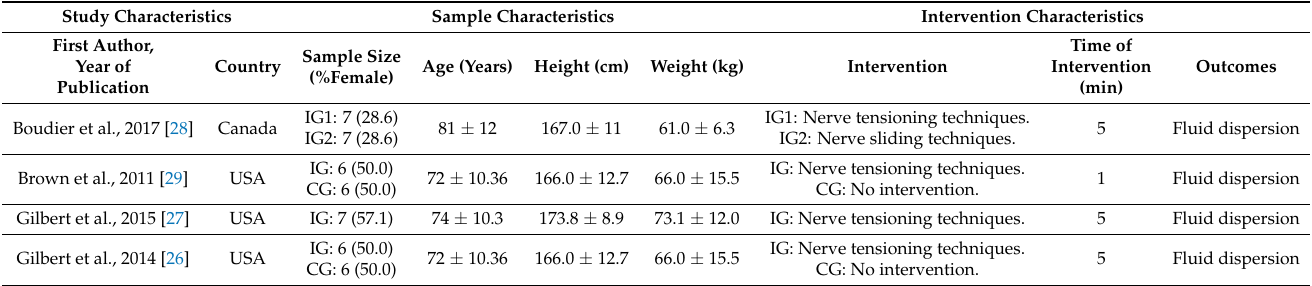
Table 1. Characteristics of the studies included in the